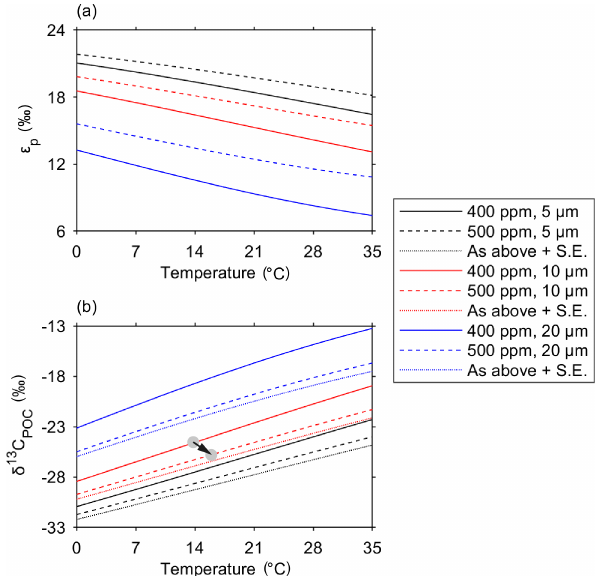
Figure 9. Projected changes in ε p and δ 13 C POC due to ongoing anthropogenic emission and upper ocean uptake of CO 2 for dif- ferent temperatures and cell sizes. Variation in ε p with seawater temperature for CO 2 partial pressures of 400ppm (solid line) and 500ppm (dashed line) and average community cell radii of 5µm (black), 10µm (red) and 20µm (blue). (b) Variation in δ 13 C POC under the same conditions as in (a) , also showing the additional isotopic change driven by the Suess effect (labelled “S.E.” and rep- resented using dotted lines). CO 2 ( aq ) is calculated using the atmo- spheric CO 2 concentration and the solubility of CO 2 in seawater (Weiss, 1974). The arrow in (b) indicates how a 100ppm increase in CO 2 and a projected 2 ◦ C increase in temperature would impact δ 13 C (with no change in cell